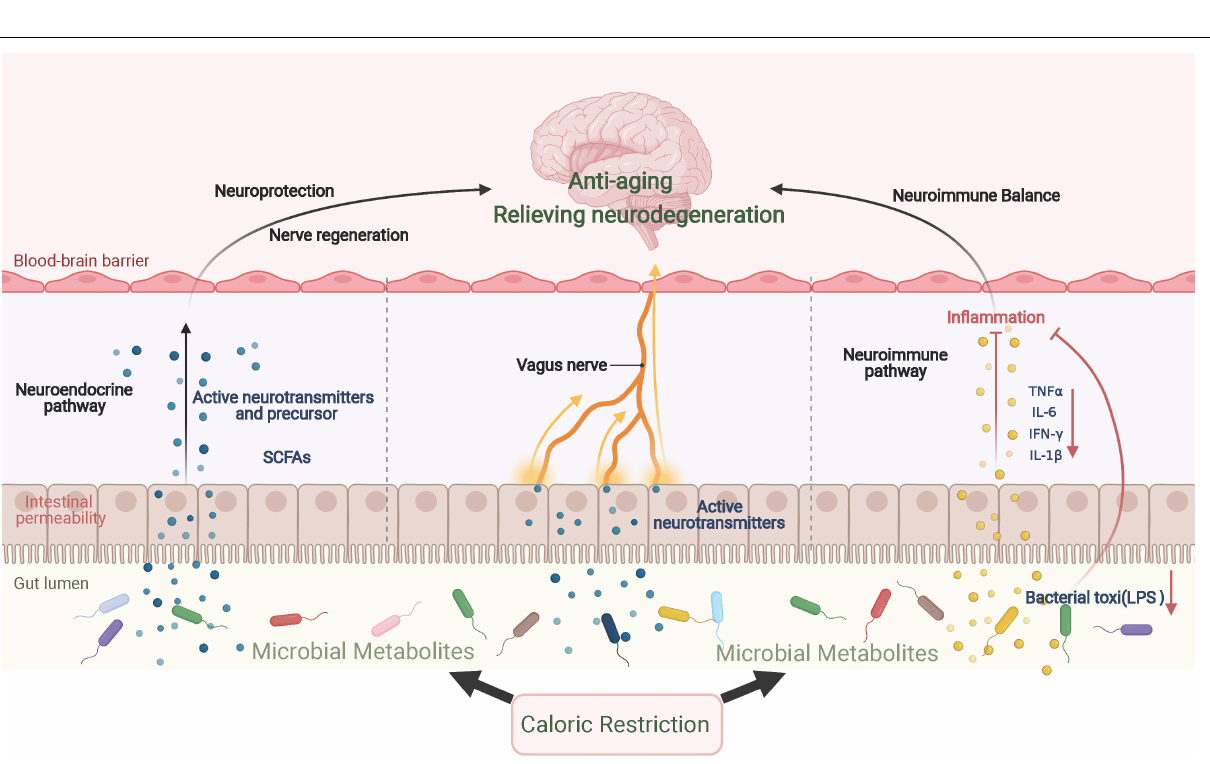
Frontiers in Physiology |